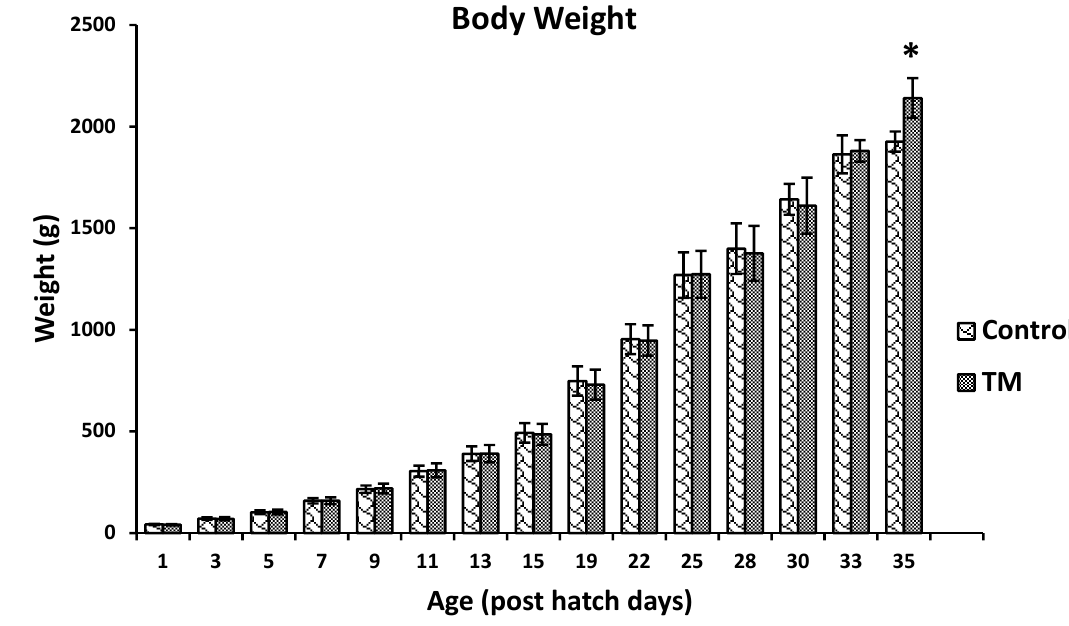
Figure 1. Effect of thermal manipulation (TM) during broiler embryogenesis on post-hatch body weights. * Within the same day, values ± SD of TM and control groups are significantly different ( P < 0.05).